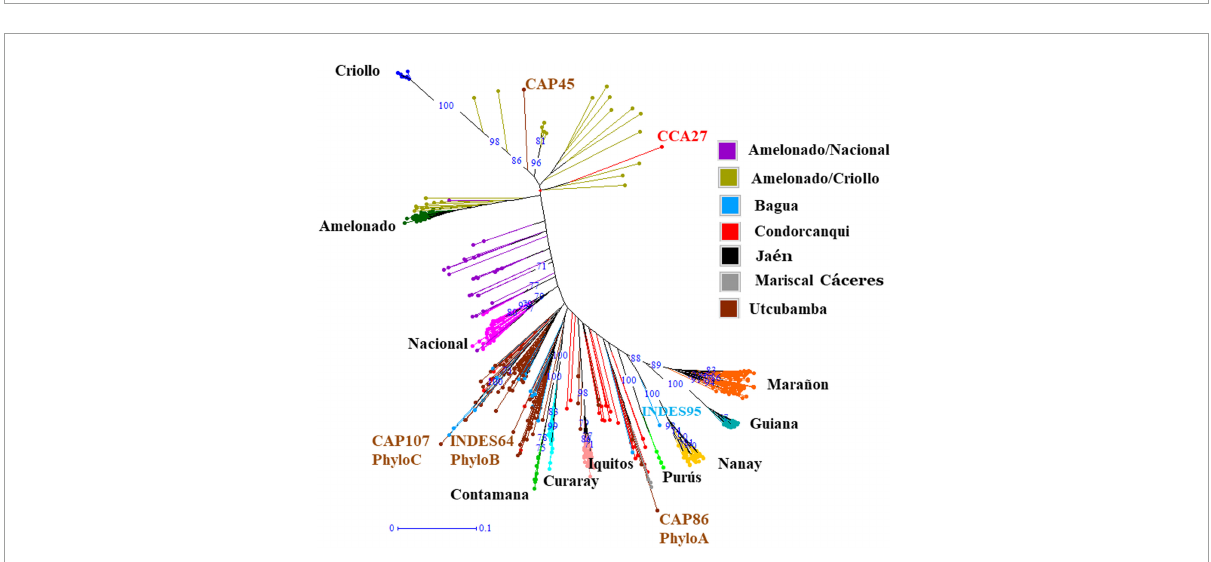
FIGURE3 Phylogram (based on 70% missing data) of unique cacao samples collected from Northern Peru (134 samples) and 390 reference accessions using 170 single nucleotide polymorphisms. Three phylogenetic clusters (PhyloA-C) from the samples from north Peru are indicated together with a representative sample. All three representative samples are from Utcubamba and each cluster also contain samples from Bagua and Condorcanqui. Three other samples from north Peru are indicated – CAP45 (Utcubamba), CCA27 (Condorcanqui) and INDES95 (Bagua). The three samples from Mariscal Cáceres are in PhyloA and the one sample from Jaén is in PhyloC. ≥ 70% bootstrap values are displayed.